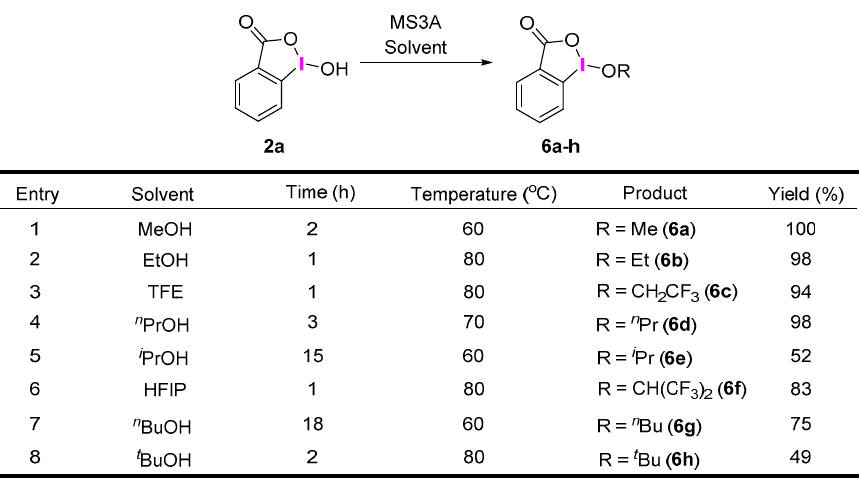
Figure 6. Benziodoxole alkoxides 6a – h by solvolytic functionalization of IBA 2a .